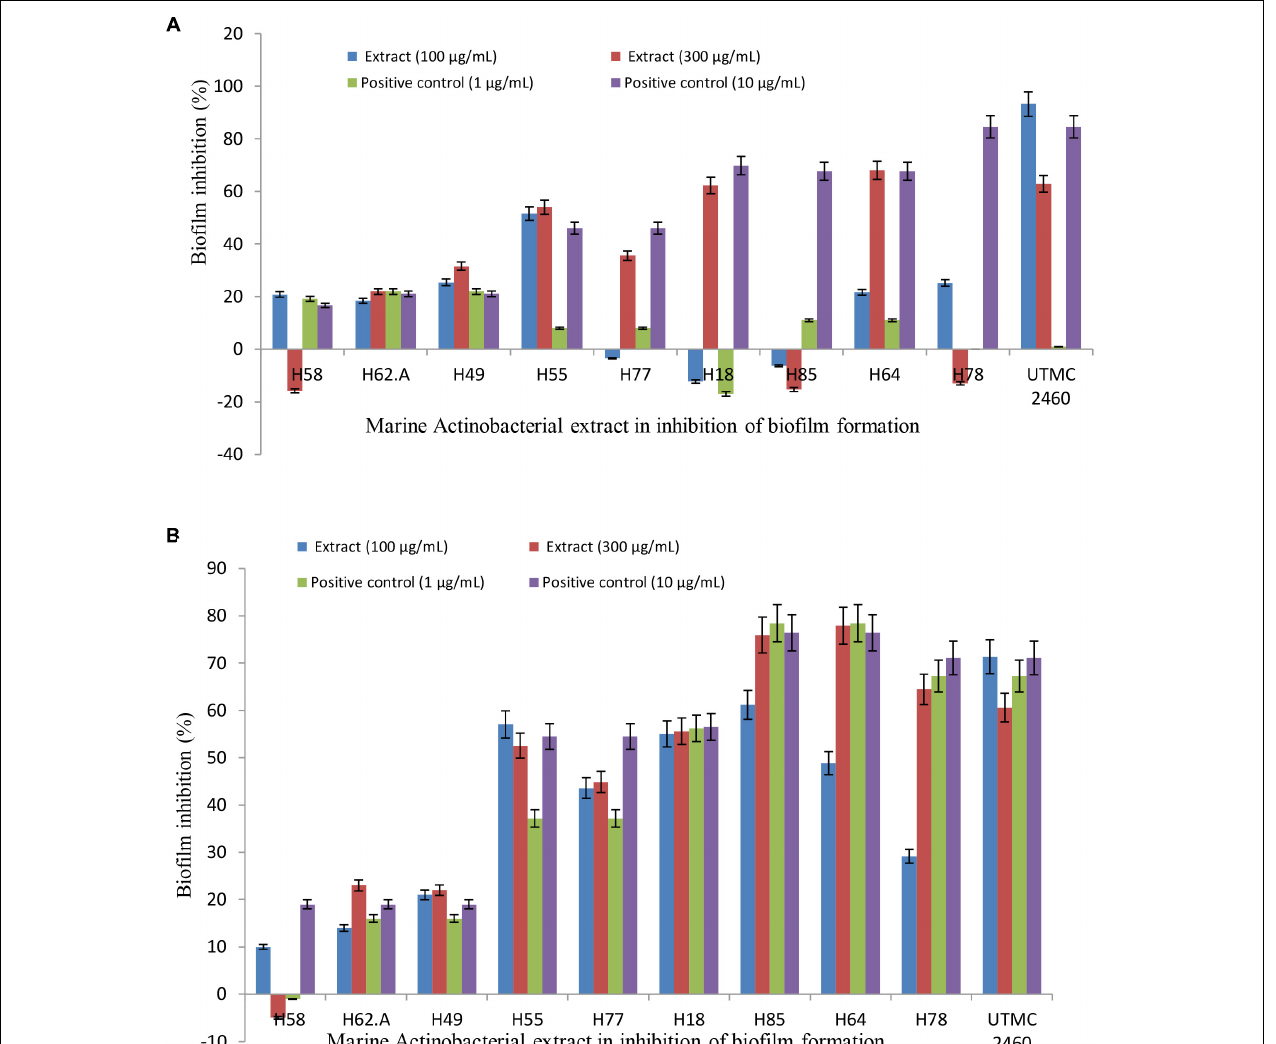
FIGURE 3 | Anti-adherence activity of Glycomyces sp. UTMC 2460 metabolite against dominant marine fouled bacteria. The graph illustrating the potential of selected marine Actinobacterial extracts (100 and 300 µ g ml − 1 ) on the adhesion prevention of marine fouling bacteria: (A) Kocuria sp. UTMC 2449 and (B) Mesorhizobium sp. UTMC 2518 in crystal violet